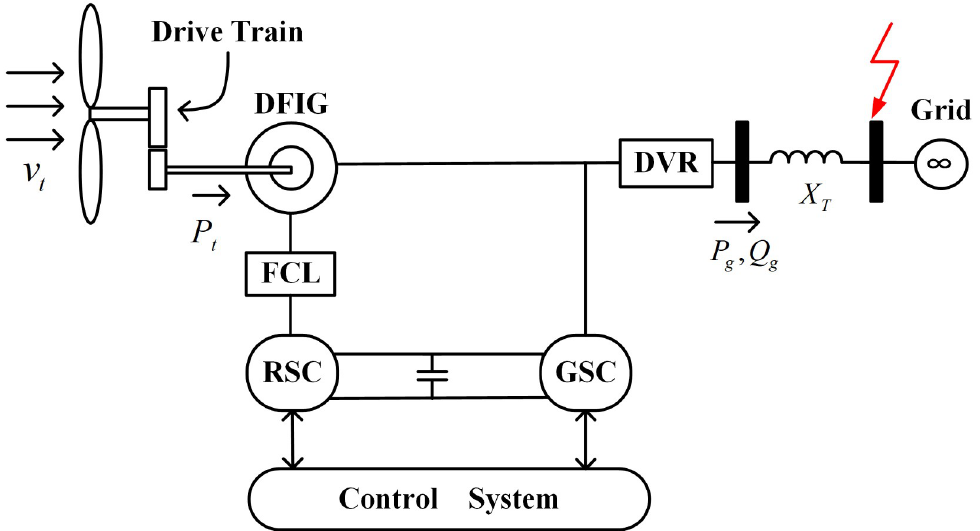
Fig 1. Schematic of a DFIG based WT with a DVR and an inductive FCL.